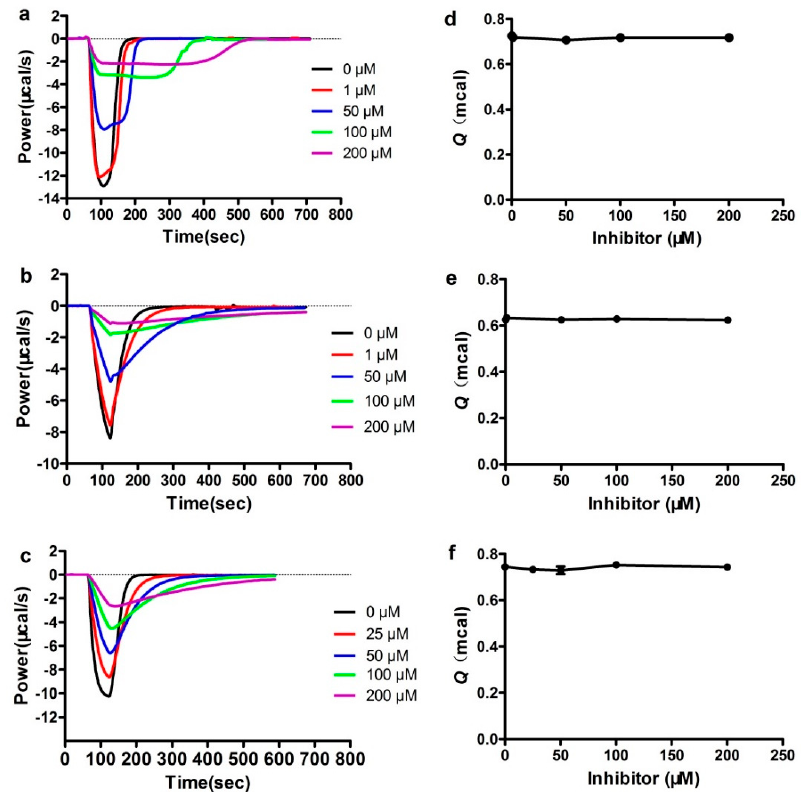
Figure 4. Overlaid heat flow curves of NDM ‐ 1 ‐ ( a , d ) and L1 ‐ ( c , f ) catalysed hydrolysis of cefazolin and ImiS ‐ catalysed hydrolysis of imipenem ( b , e ) in the absence and presence of DC1 at a concentration range of 1–200 μ M, using a single injection mode ITC assay at 25 °C.